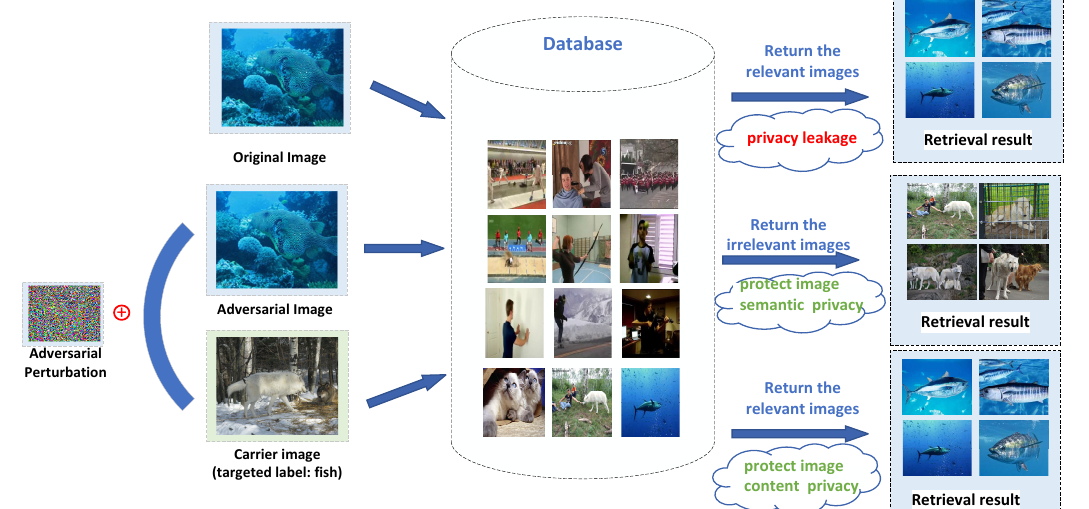
Figure 1. Three kinds of queries. The first row is the original query, which may encounter the threat of privacy leakage during the retrieval process. In the second row, we conduct adversarial attacks on the images uploaded by users to social platforms. This can ensure that the semantic information of images will not be retrieved by the retrieval system, resulting in the leakage of image semantic privacy. In the third row, we conduct a targeted adversarial attack on a carrier image. The target label is the same as the original image. This retrieval can be carried out by uploading the carrier image without uploading the original image, which can protect the image content